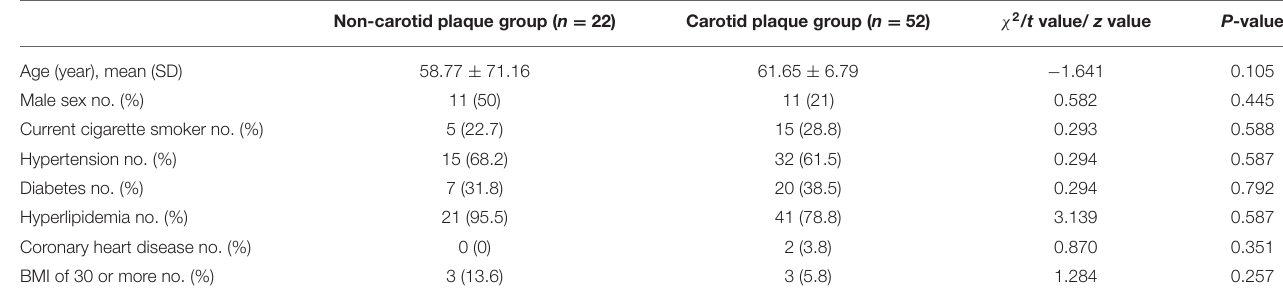
TABLE 1 | Demographic and clinical characteristics of the